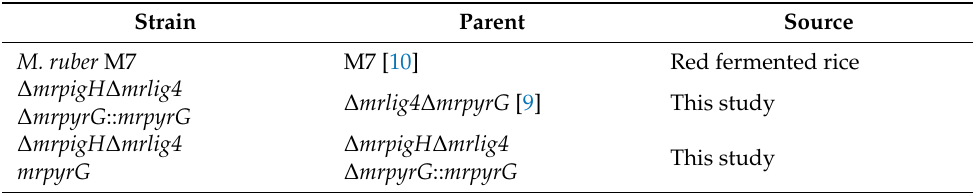
Table 1. M. ruber strains constructed and used in this study. Strain Parent Source M. ruber M7 M7 [10]